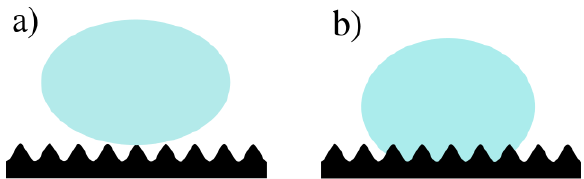
Figure 1. Droplets in ( a ) Cassie–Baxter state and in ( b ) Wenzel state.